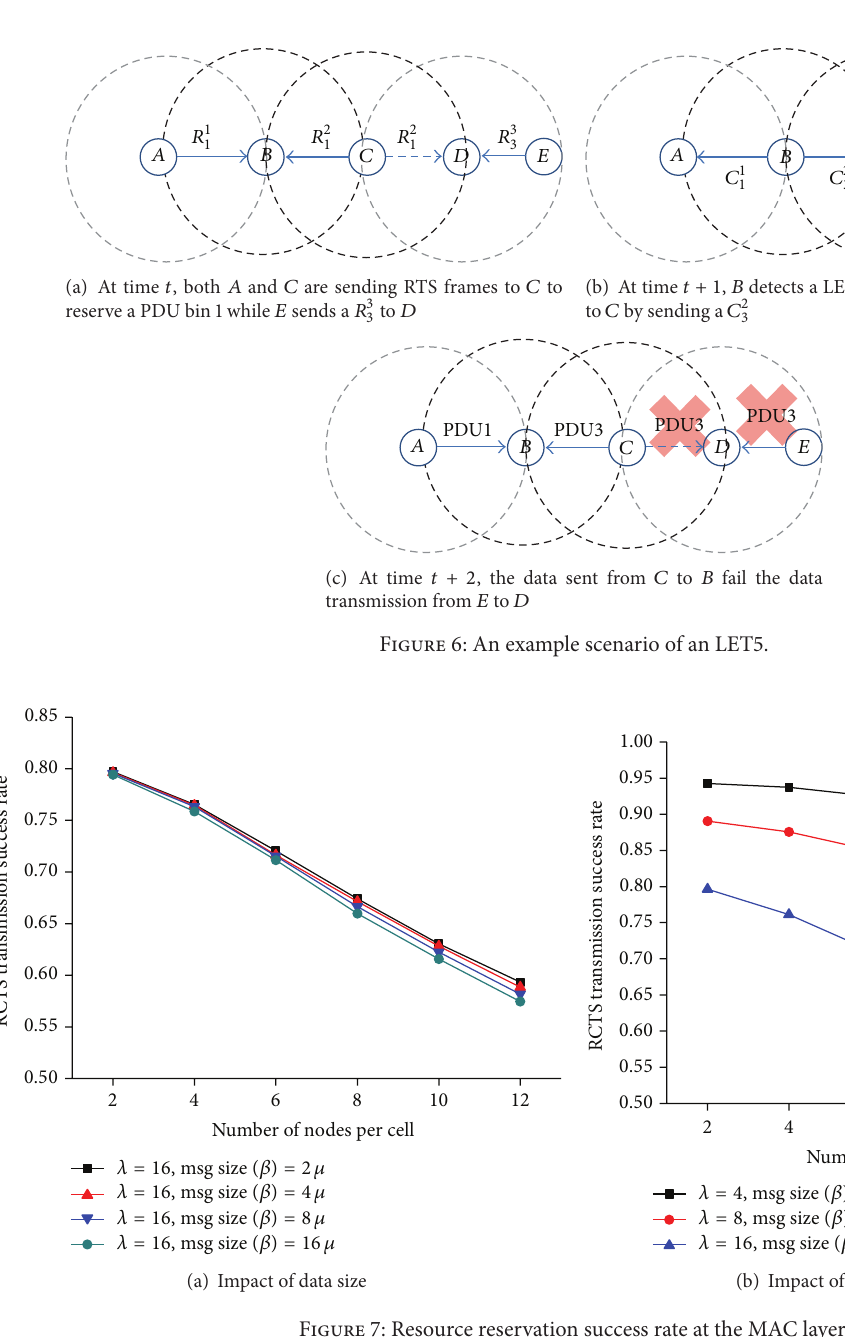
Figure 7: Resource reservation success rate at the MAC